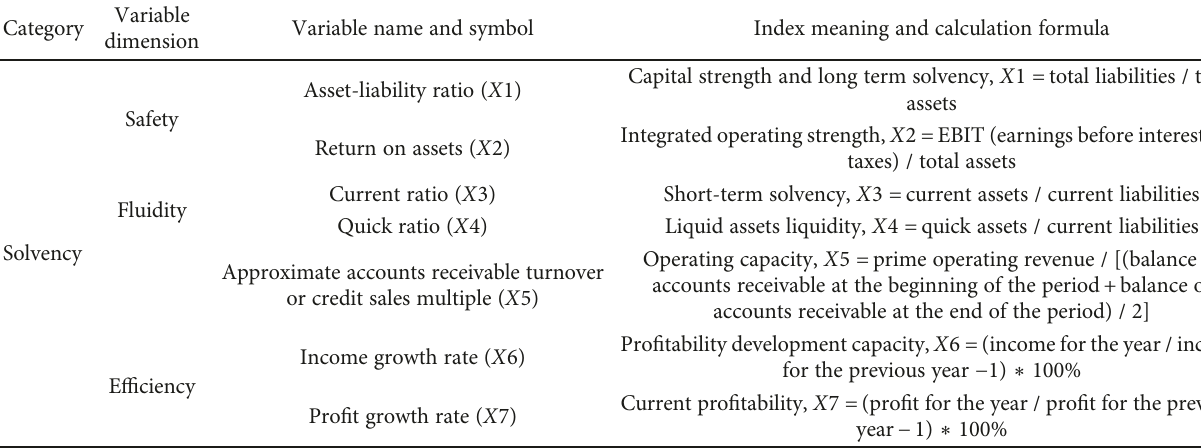
Table 1: Buyer ’ s solvency